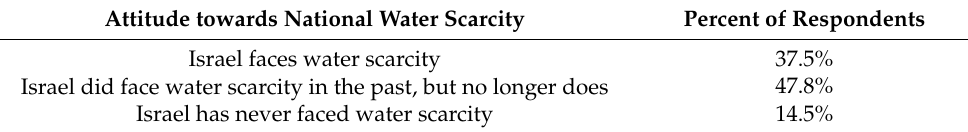
Table 1. Public perceptions of water scarcity ( n =